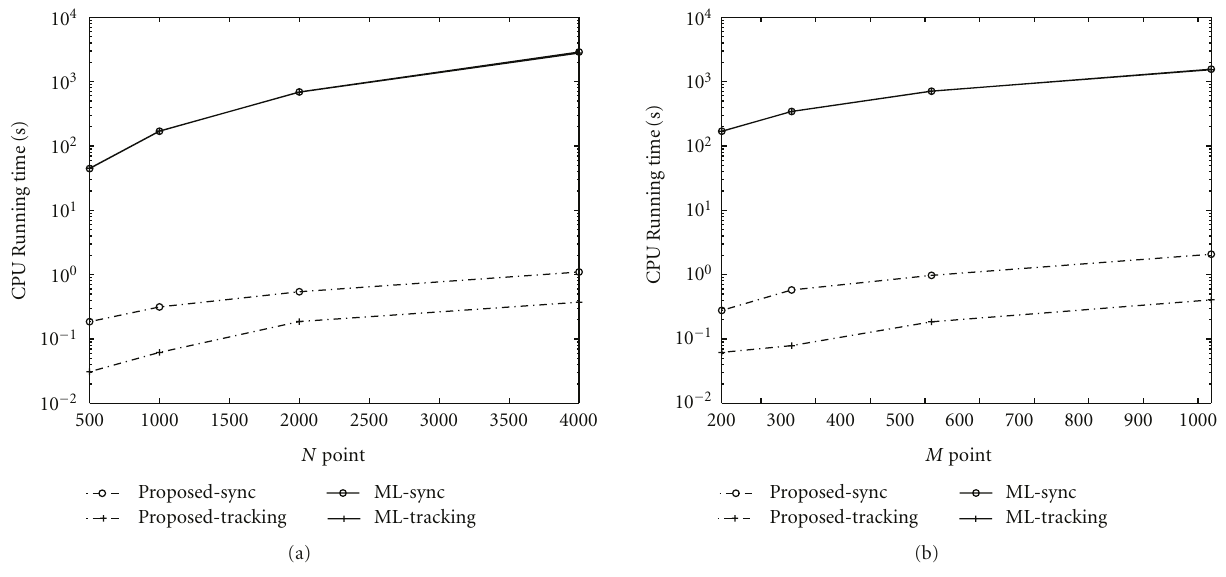
Figure 8: Comparison of CPU time. (a) Fixed M = 128 and N = 500 ∼ 4000 and (b) fixed N = 1000 and M = 128 ∼ 1024.